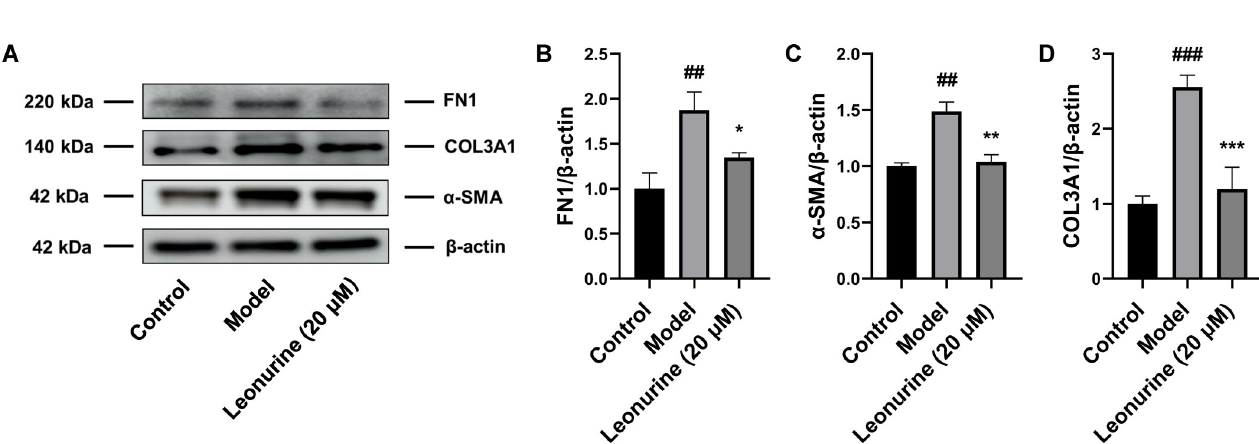
Fig 6. Leonurine reduced the expression of proteins related to fibrosis in H9c2 cells stimulated by TGF- β . (A) Compared to H9c2 cells induced by TGF- β for 48 hours, leonurine decreased the expression of proteins related to fibrosis including (B) FN1, (C) α -SMA, and (D) COL3A1. #P < 0.01, ###P < 0.001, model group vs. control group; � P < 0.05, �� P < 0.01, ��� P < 0.001, 20 μ M leonurine group vs. model group.